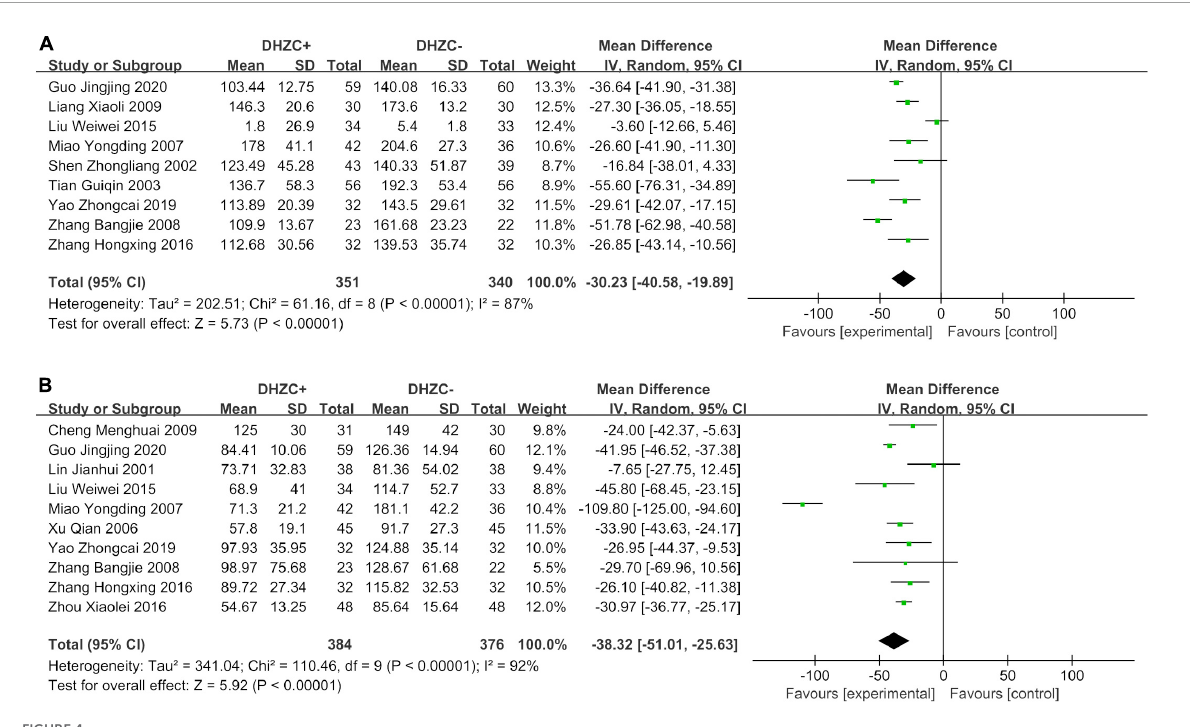
were no significant differences in Tbil between the DHZCP- based therapy group and the control group after 6 months